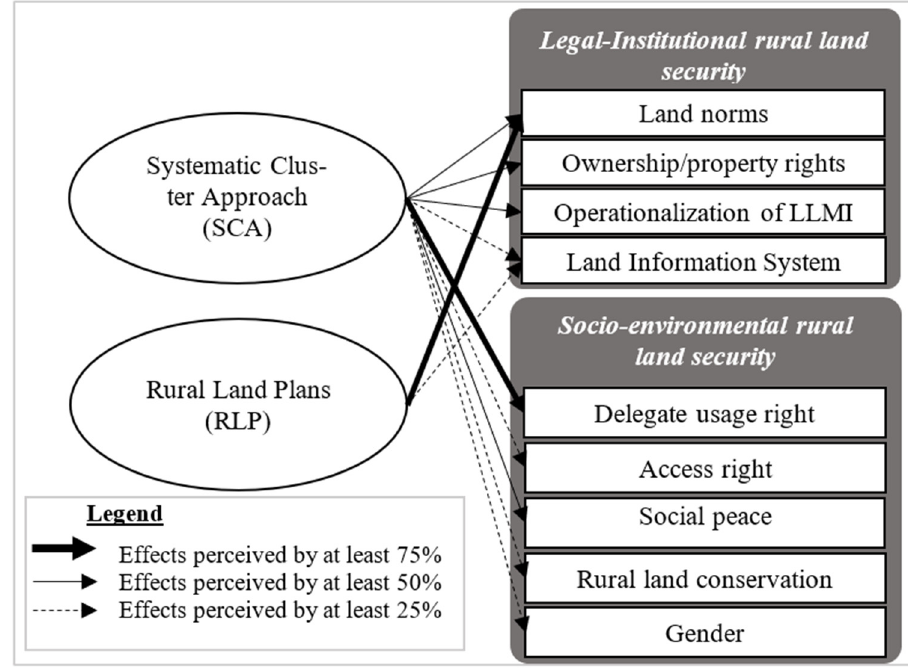
Figure 3. Contributions of the SCA and RLP approach to land tenure security.